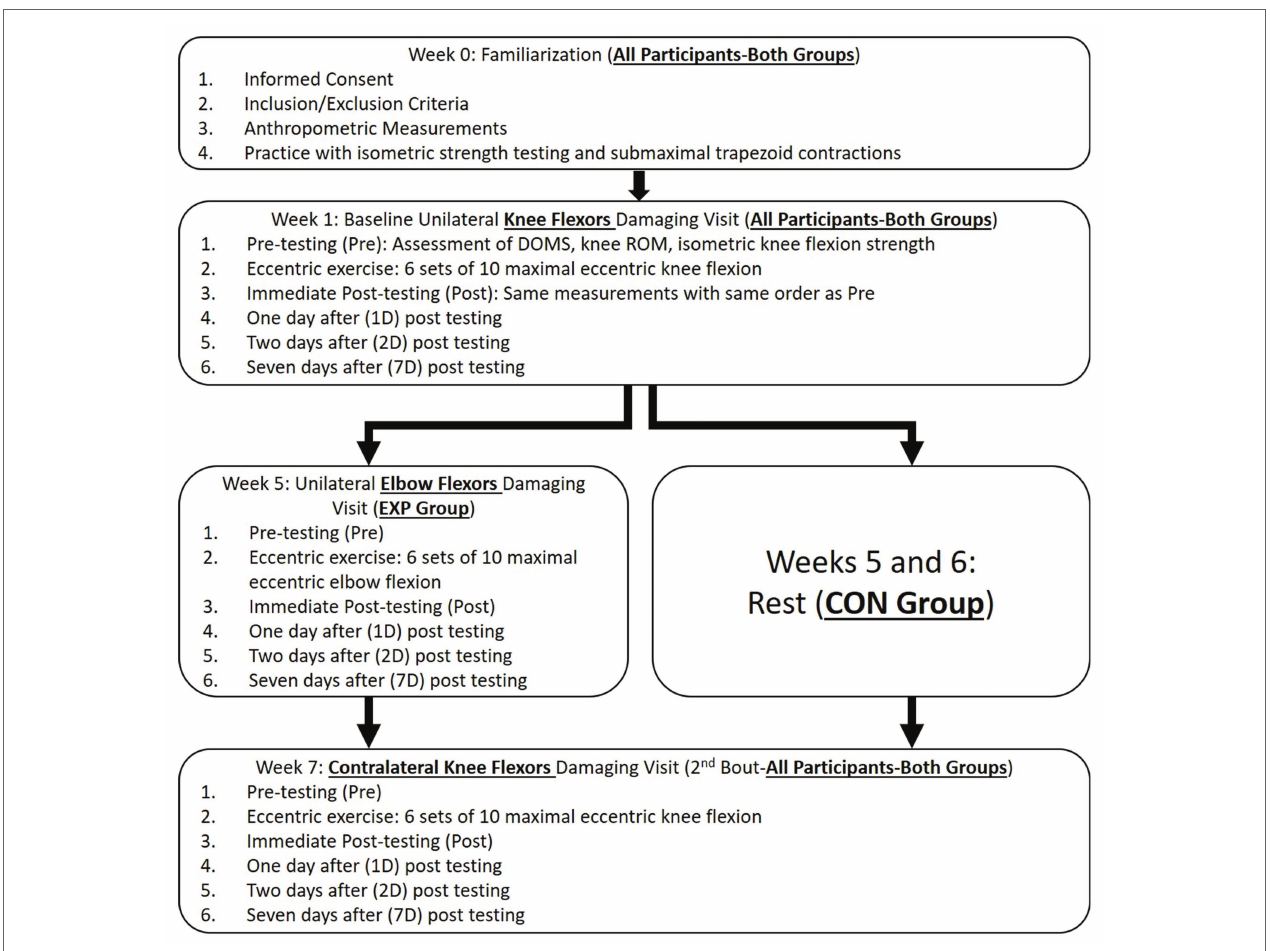
FIGURE 1 | Study design and the procedure flowchart of the experiment. DOMS: delayed onset muscle soreness; ROM: range of motion; EXP: experimental group; and CON: control